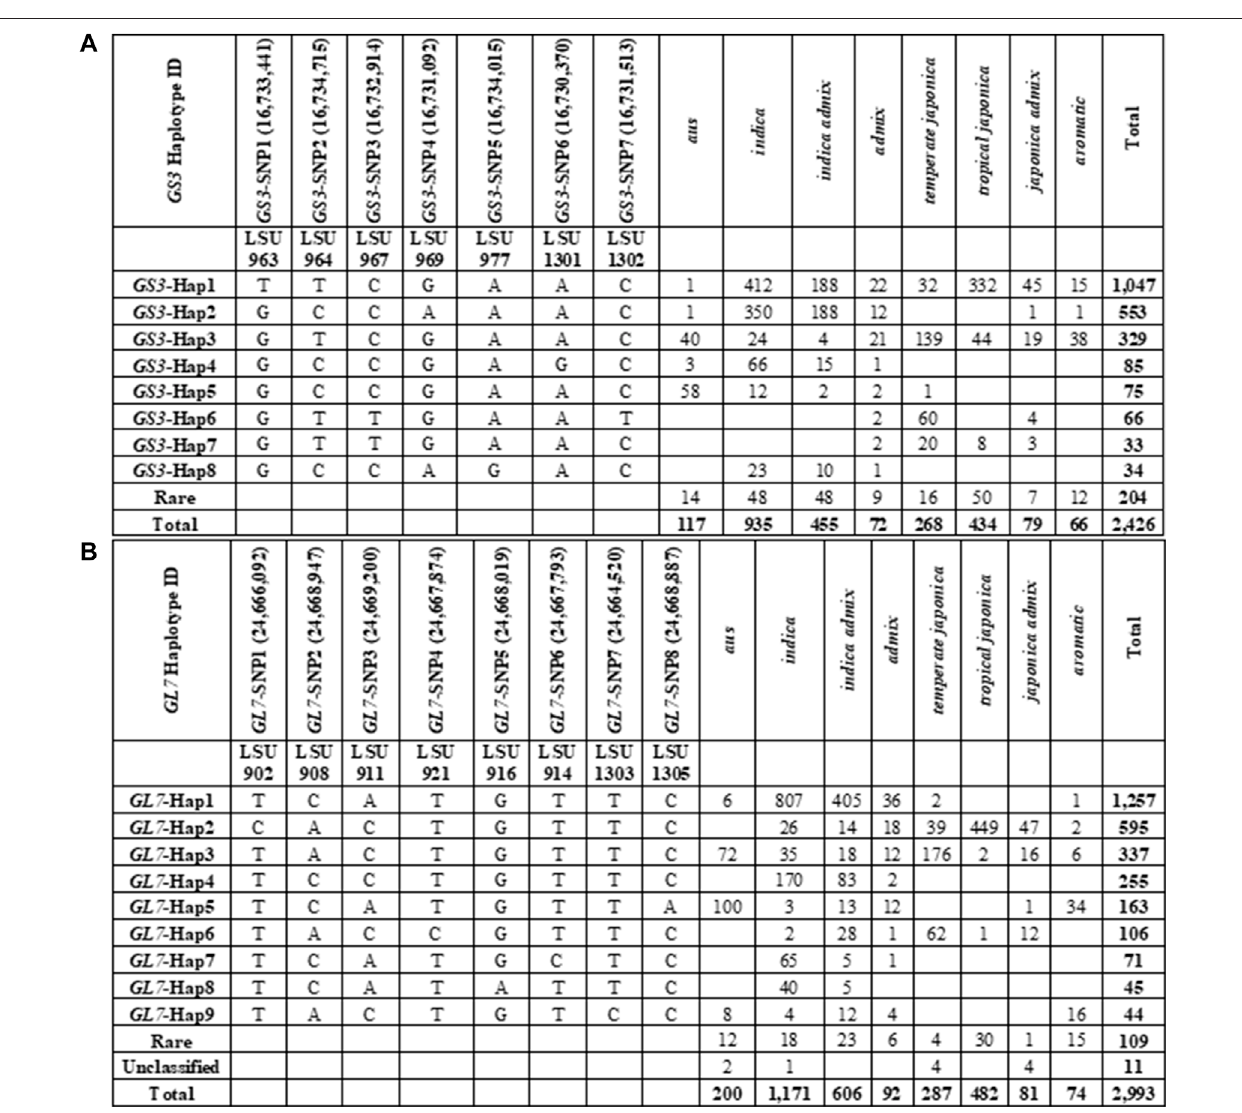
Frontiers in Genetics |